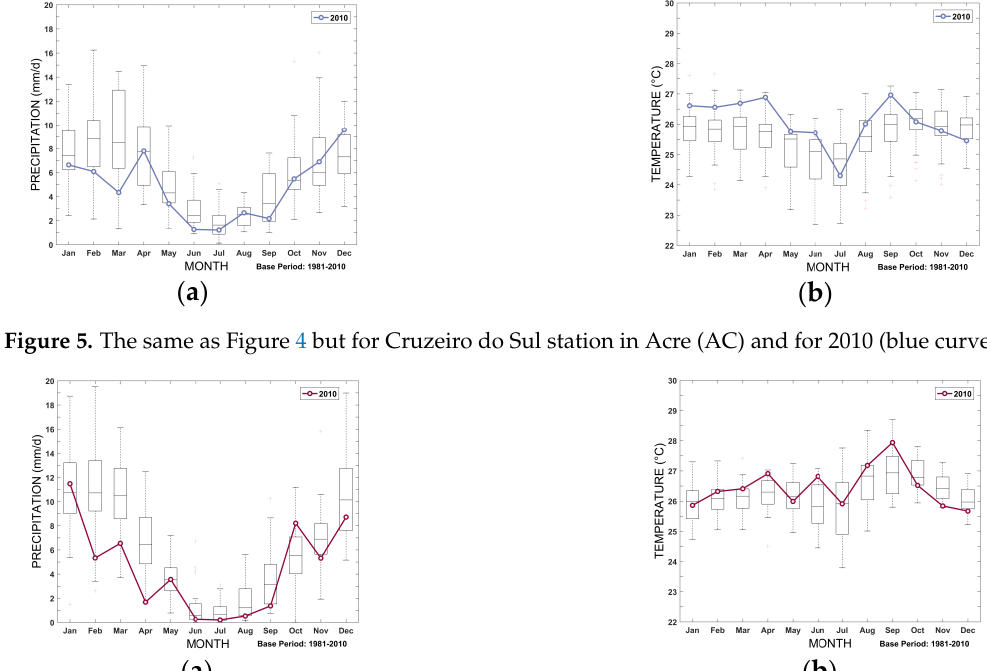
Figure 4. Intra-annual variability of observed: ( a ) precipitation (mm/d) and ( b ) temperature (°C, right panel) monthly values at the Coari station in Amazonas (AM). Each monthly boxplot represents the historical distribution for the 1981 – 2010. The green curve depicts the above variables for the year of 2005.